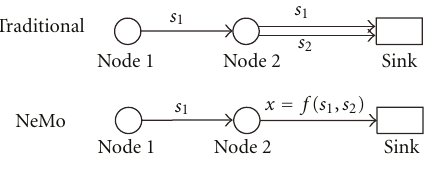
Figure 1: A two-node